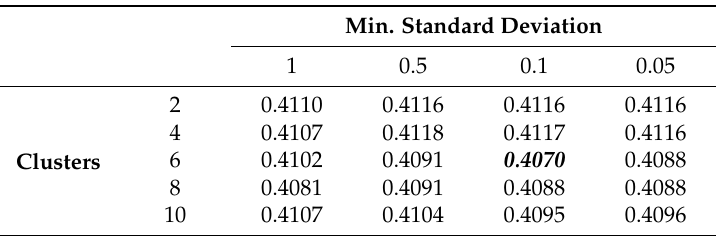
Table A7. Sensitivity of radial basis function networks (RBFN) to the number of basis functions and their minimum standard deviations, the average over three runs.